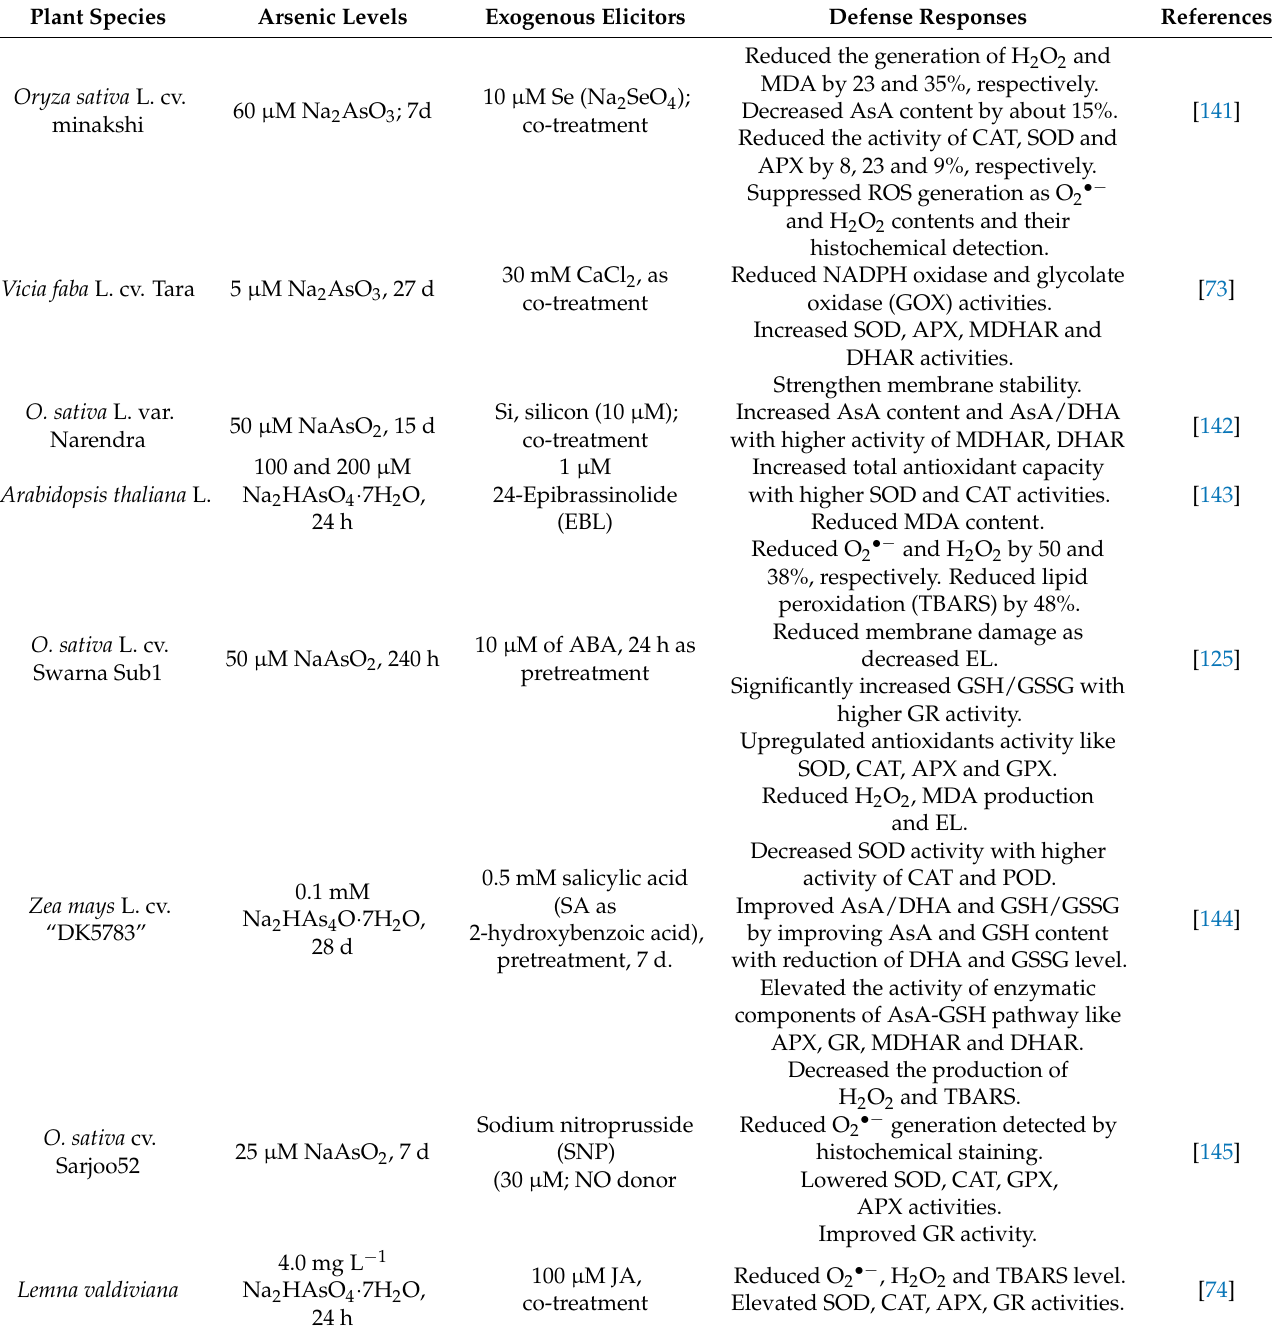
Table 4. Exogenous elicitors-mediated oxidative stress tolerance in plant under arsenic